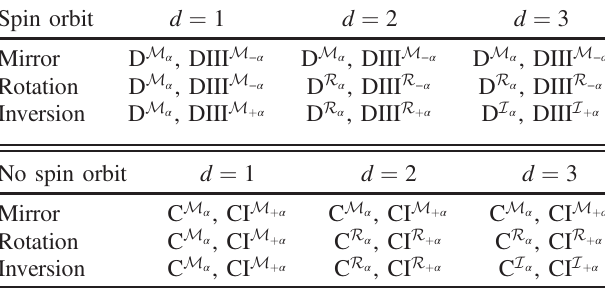
TABLE IX. Shiozaki-Sato classes that correspond to natural physical realizations of the order-two symmetries for super- conductors with (top) and without (bottom) strong spin-orbit coupling. For the time-reversal invariant superconductors the tenfold-way class is DIII or CI, otherwise it is class D or C. The parity of the superconducting order parameter under the